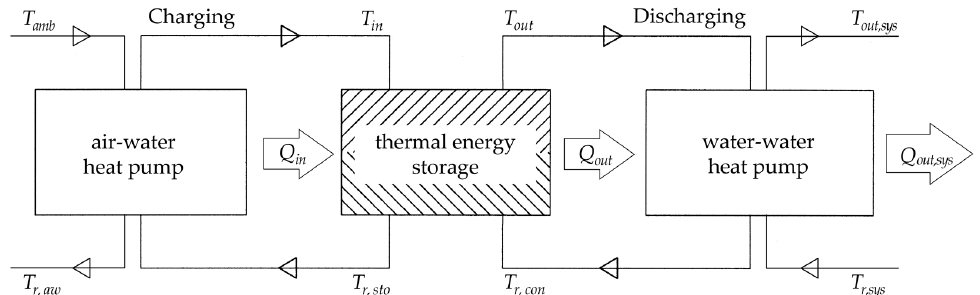
Figure 13. The BTES system modeled in this work.